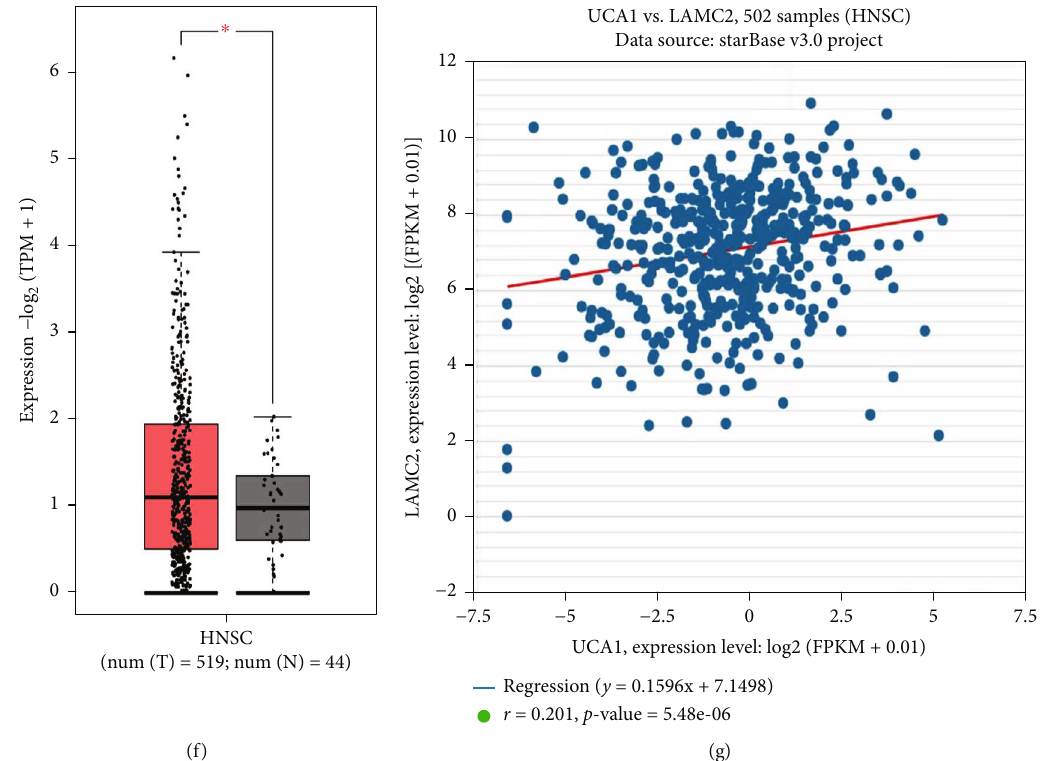
Figure 2: UCA1 modulates the LAMC2/PI3K/AKT axis in OSCC-CSCs via binding miR-134. (a) Heat map of di ff erentially expressed genes among three normal tissues and eight OSCC tissues in the GSE146483 dataset. (b) Volcano map of di ff erentially expressed genes among three normal tissues and eight OSCC tissues in the GSE146483 dataset. (c) Venn diagram of the intersection between lncRNAs binding miR-134 in the RNAInter database and downregulated lncRNAs in OSCC in GSE146483. (d) The binding sites of UCA1 and miR-134. (e) Dual-luciferase reporter assays detecting the binding relationship between UCA1 and miR-134. (f) The expression of UCA1 in the TCGA dataset, analyzed with the GEPIA database (red represents OSCC tissues, n = 519 ; black represents normal tissues, n = 44 ). (g) The correlation between UCA1 and LAMC2 expression in HNSCC samples ( n = 502 ) from the TCGA dataset according to starBase database analysis. ∗ p < 0 : 05 , # p > 0 : 05 . All cell experiments were repeated three (Figure 3(f)). Hence, UCA1 modulates the PI3K/AKT path- way via targeting LAMC2 in macrophages.